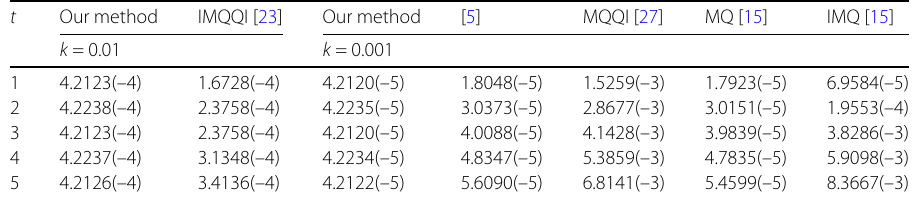
Table 6 Comparison of L ∞ error with [5, 15, 23, 27] for p = 30, σ = 1 [ a , b ] = [0,40] for Example